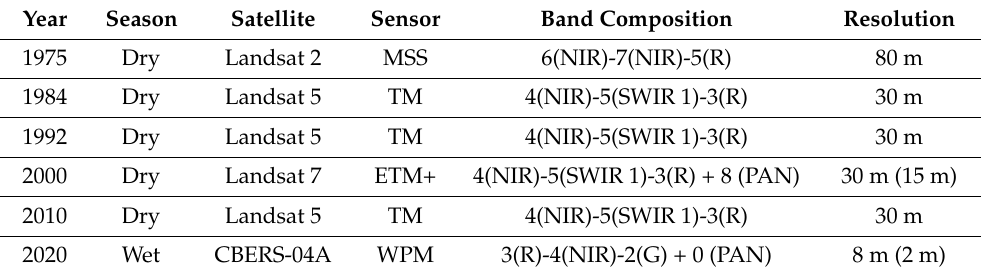
Table 1. Technical characteristics of acquisition and processing of the satellite images dataset used in the